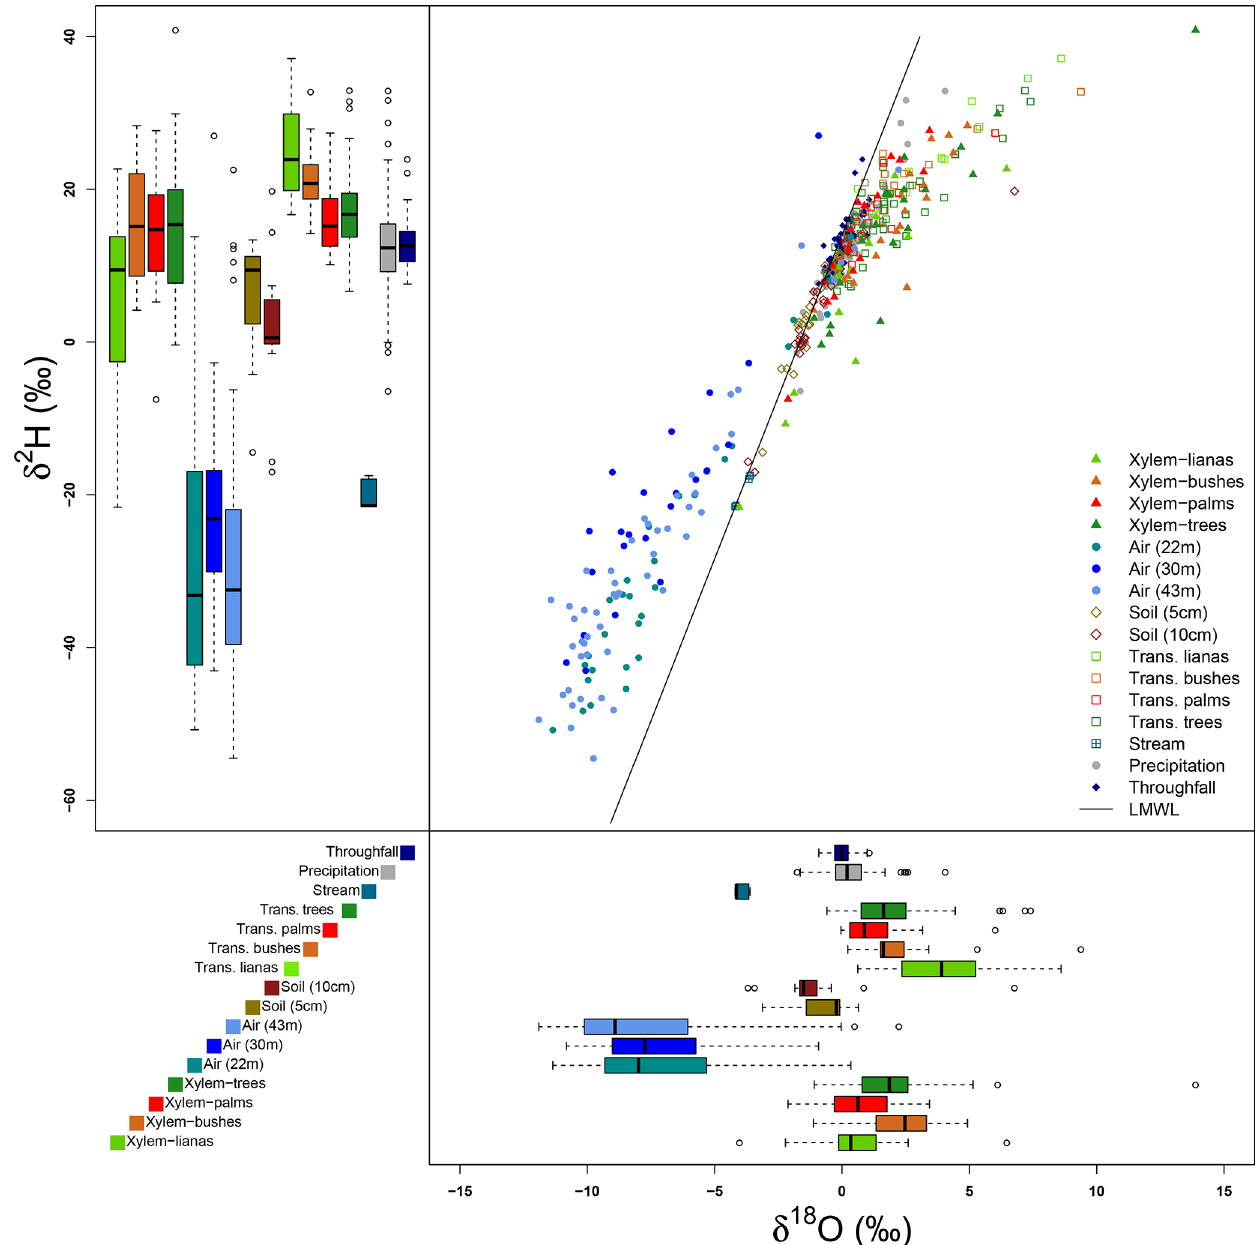
Figure 6. Isotopic signatures of δ 2 H and δ 18 O of all the samples collected at the MRI plot. The dual isotope plot shows the relationship among the local meteoric water line (LMWL) and all the samples. The box plots of δ 2 H (upper–left) and δ 18 O (bottom–right) show the distribution of isotope signatures per sample